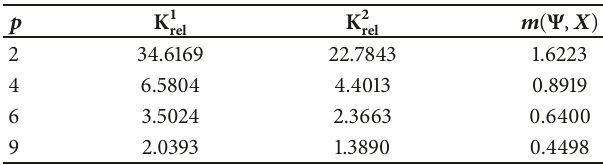
Table 2: Normwise and mixed condition numbers for different 𝑝 - values using an ill-conditioned input matrix 𝐴